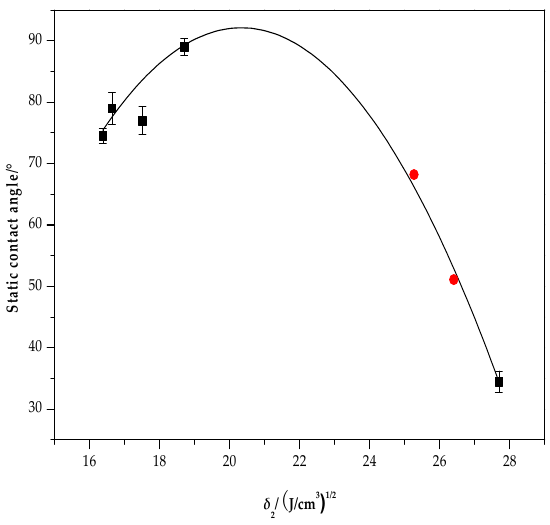
Figure 7. Contact angle vs the solubility parameter ( δ 2 ) of alkali lignin/PVA composite membranes.